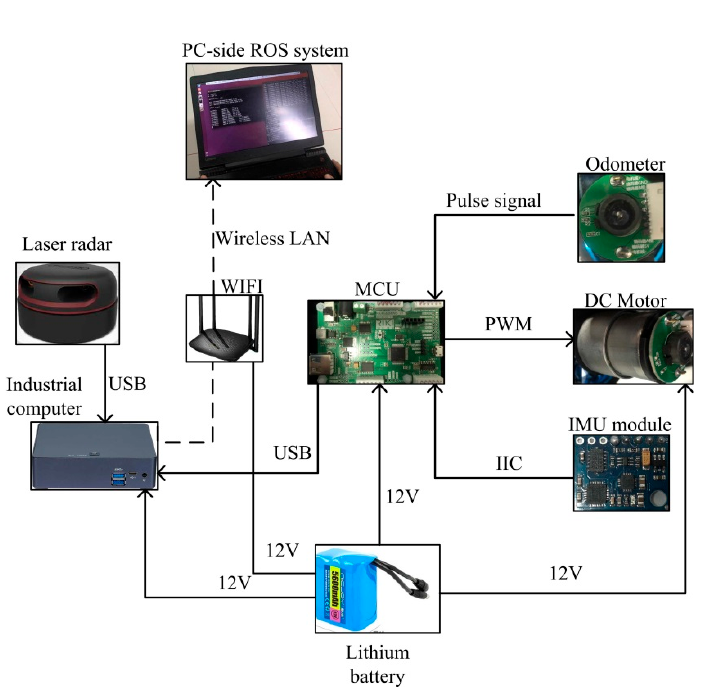
Figure 7. Rikirobot. Sensors 2019 , 19 , x FOR PEER REVIEW